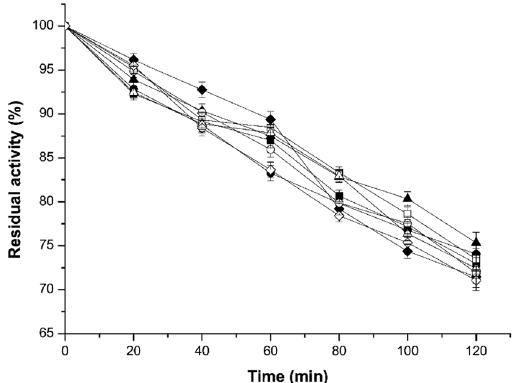
Figure 5. Acidic stability of wild-type xylanase and its mutants. The purified xylanases were diluted in Na 2 HPO 4 -citric acid buffer (pH 2.2) and incubated for 20 min, 40 min, 60 min, 80 min, 100 min and 120 min at room temperature. ■ , wild-type xylanase; ● , T53C-T142C; ▲ , T46P; ♦ , S136P; □ , T53C-T142C/T46P; ○ , T53C-T142C/S136P; ∆ , T46P-S136P; ◊ ,